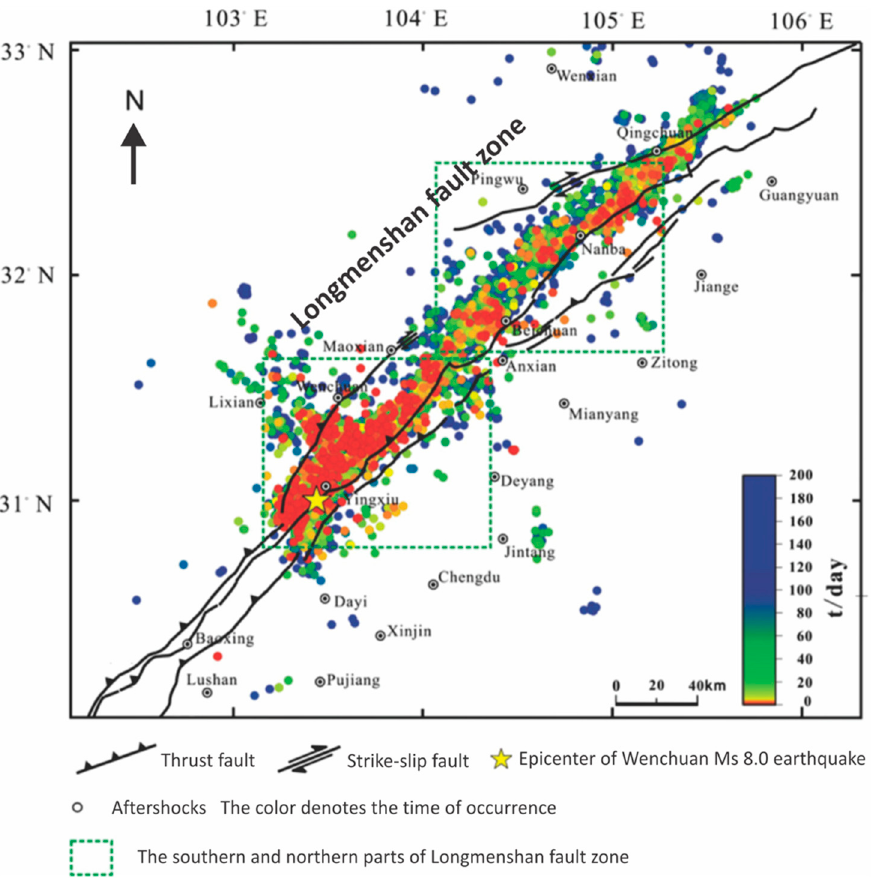
Figure 1. Spatiotemporal distributions of aftershocks [1]. Reproduced with permission from Liu et al., Tectonophysics; published by Elsevier, 2014, with Number